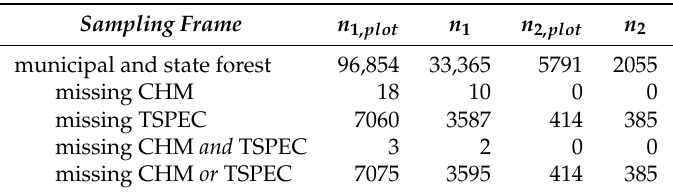
Table 2. Sample size for each phase in entire study area. n { 1,2 } , plot : number of plots. n { 1,2 } : number of clusters. TSPEC: tree species map